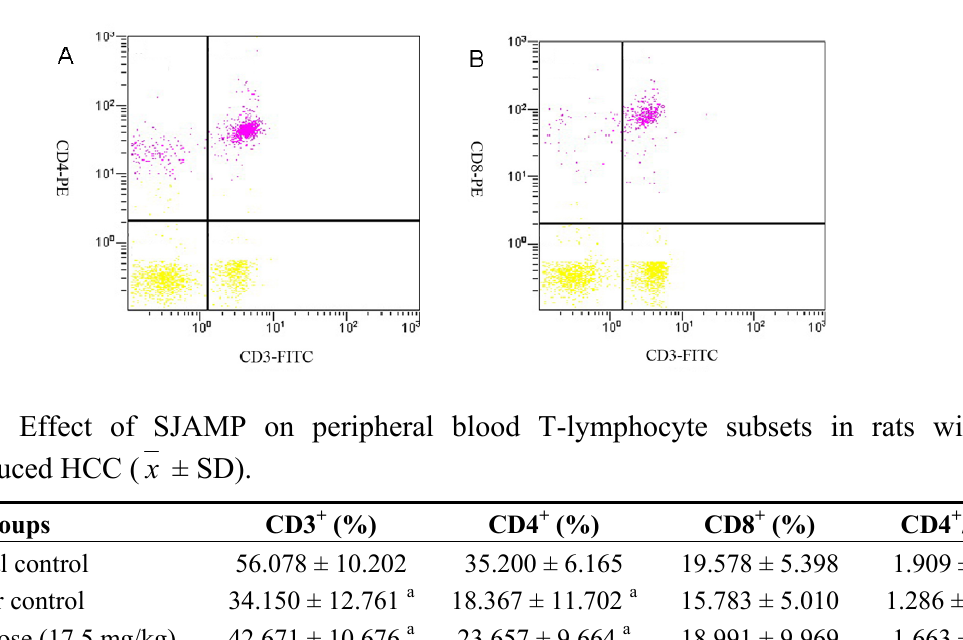
(A ) Flow cytometric analysis of staining for CD3 + (x-axis) and CD4 + (y-axis) cells in the tumor control group. The CD3 + cells are represented in lower right quadrant, and the CD4 + cells are represented in the upper left quadrant. The CD3 + CD4 + cells are represented in the upper right quadrant; ( B ) Flow cytometric analysis of staining for CD3 + (x-axis) and CD8 + (y-axis) cells in the tumor control group. The CD3 + cells are represented in the lower right quadrant, and the CD8 + cells are represented in the upper left quadrant. The CD3 + CD8 + cells are represented in the upper right quadrant.